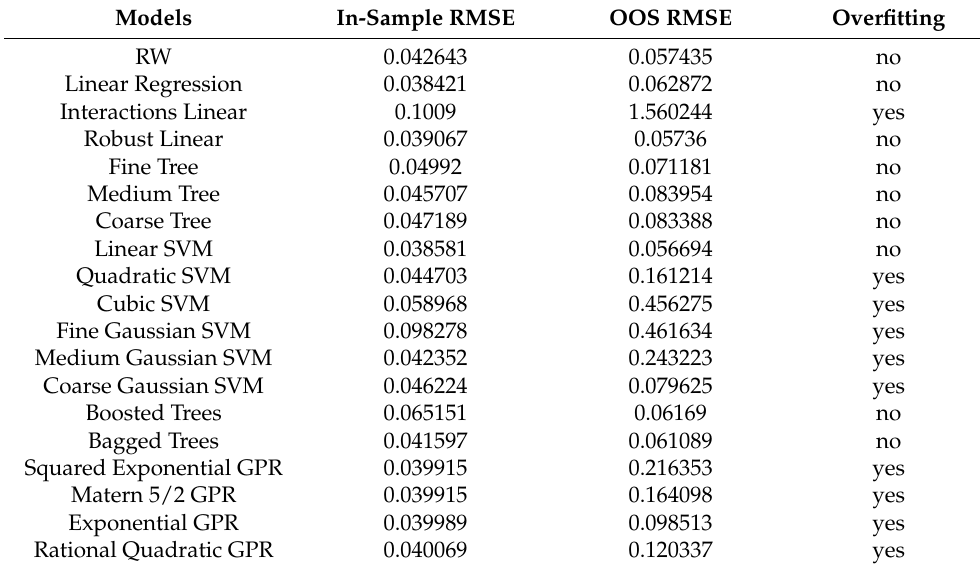
Table 2. In-sample and out-of-sample (OOS) RMSE of all